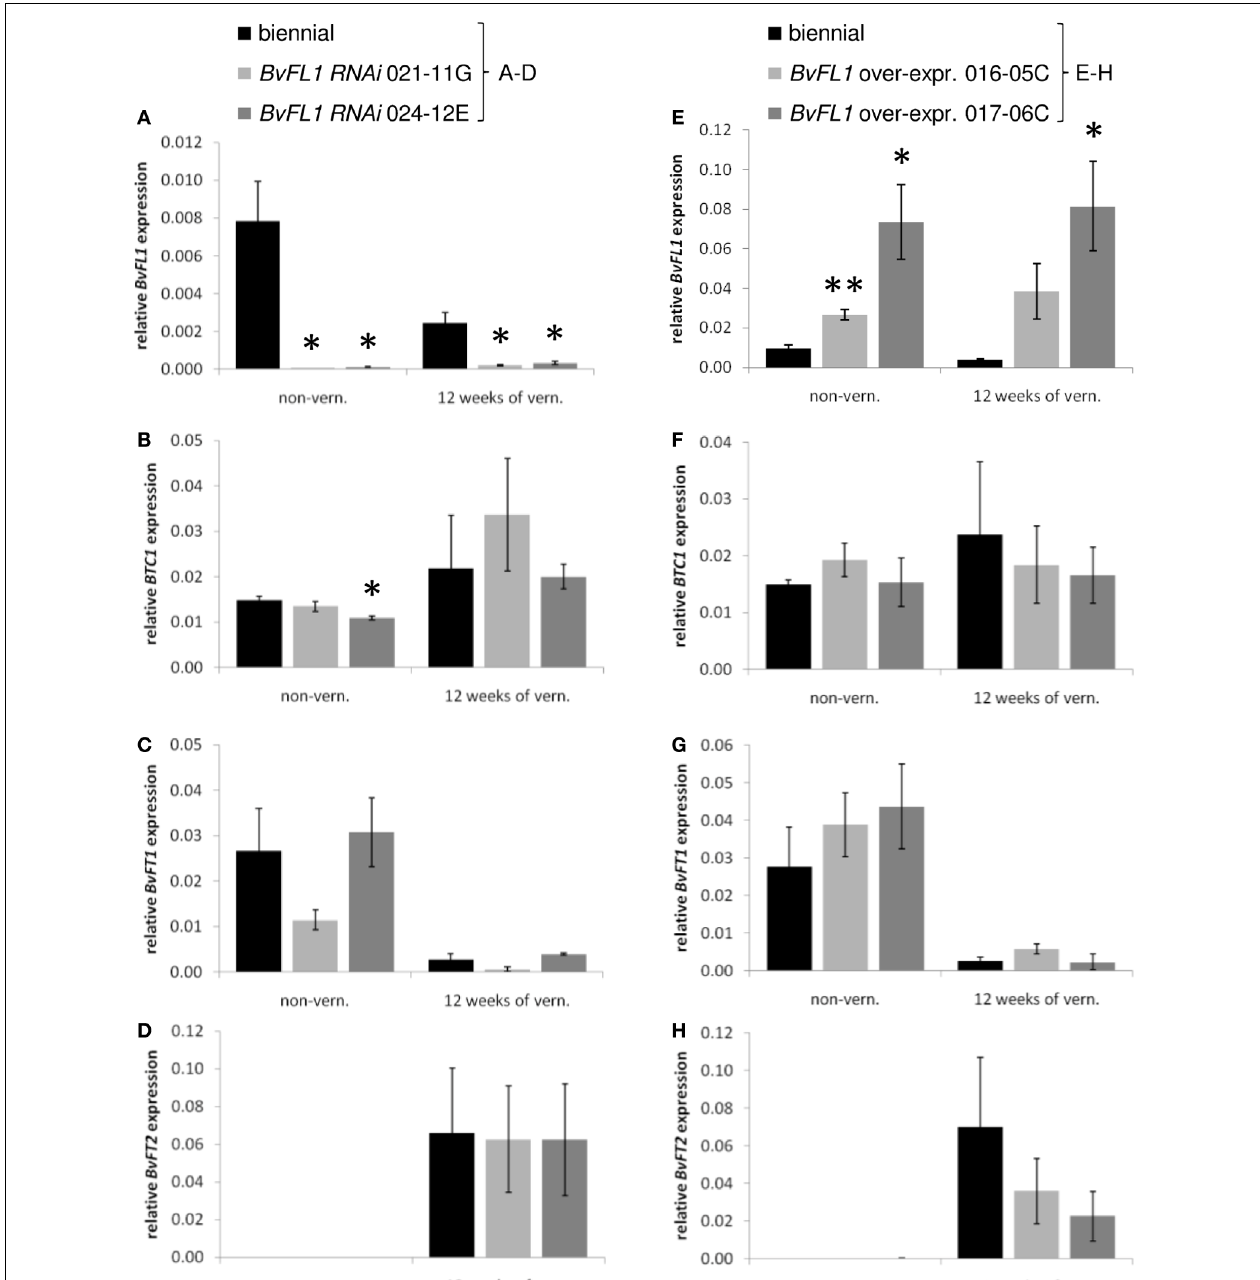
FIGURE 2 | Expression of floral regulators in BvFL1 RNAi (A–D) and BvFL1 over-expression(E–H)transformants. Expressionof BvFL1 (A,E) andthefloral regulators BTC1 (B,F) , BvFT1 (C,G) ,and BvFT2 (D,H) wasmeasuredinleavesof non-vernalized plants and at the end of a 12-week vernalization period at ZT 6-8